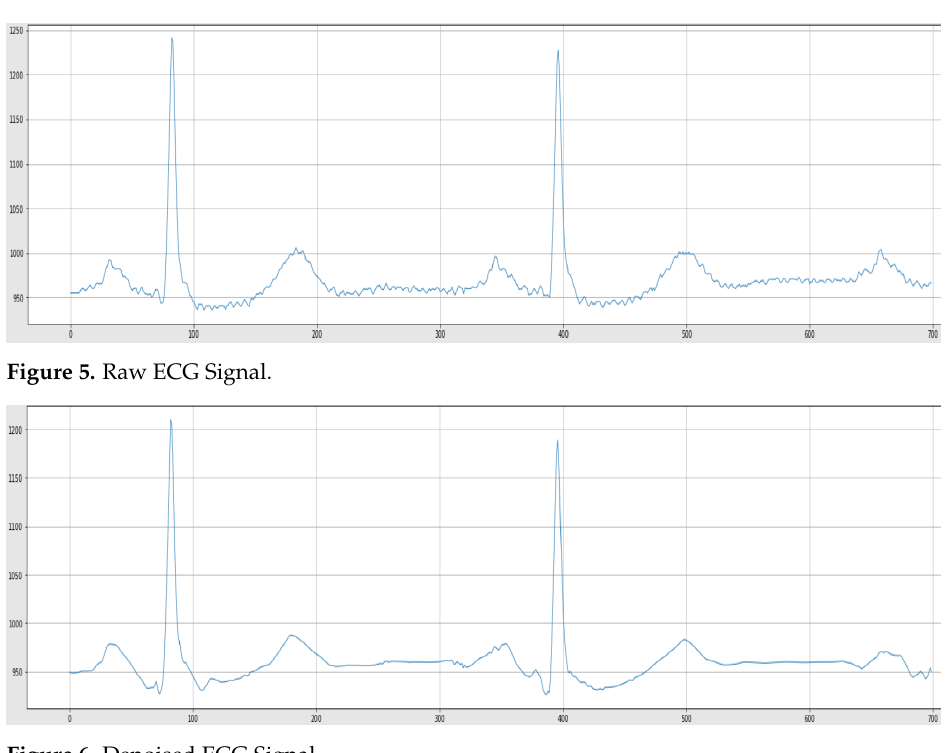
Figure 6. Denoised ECG